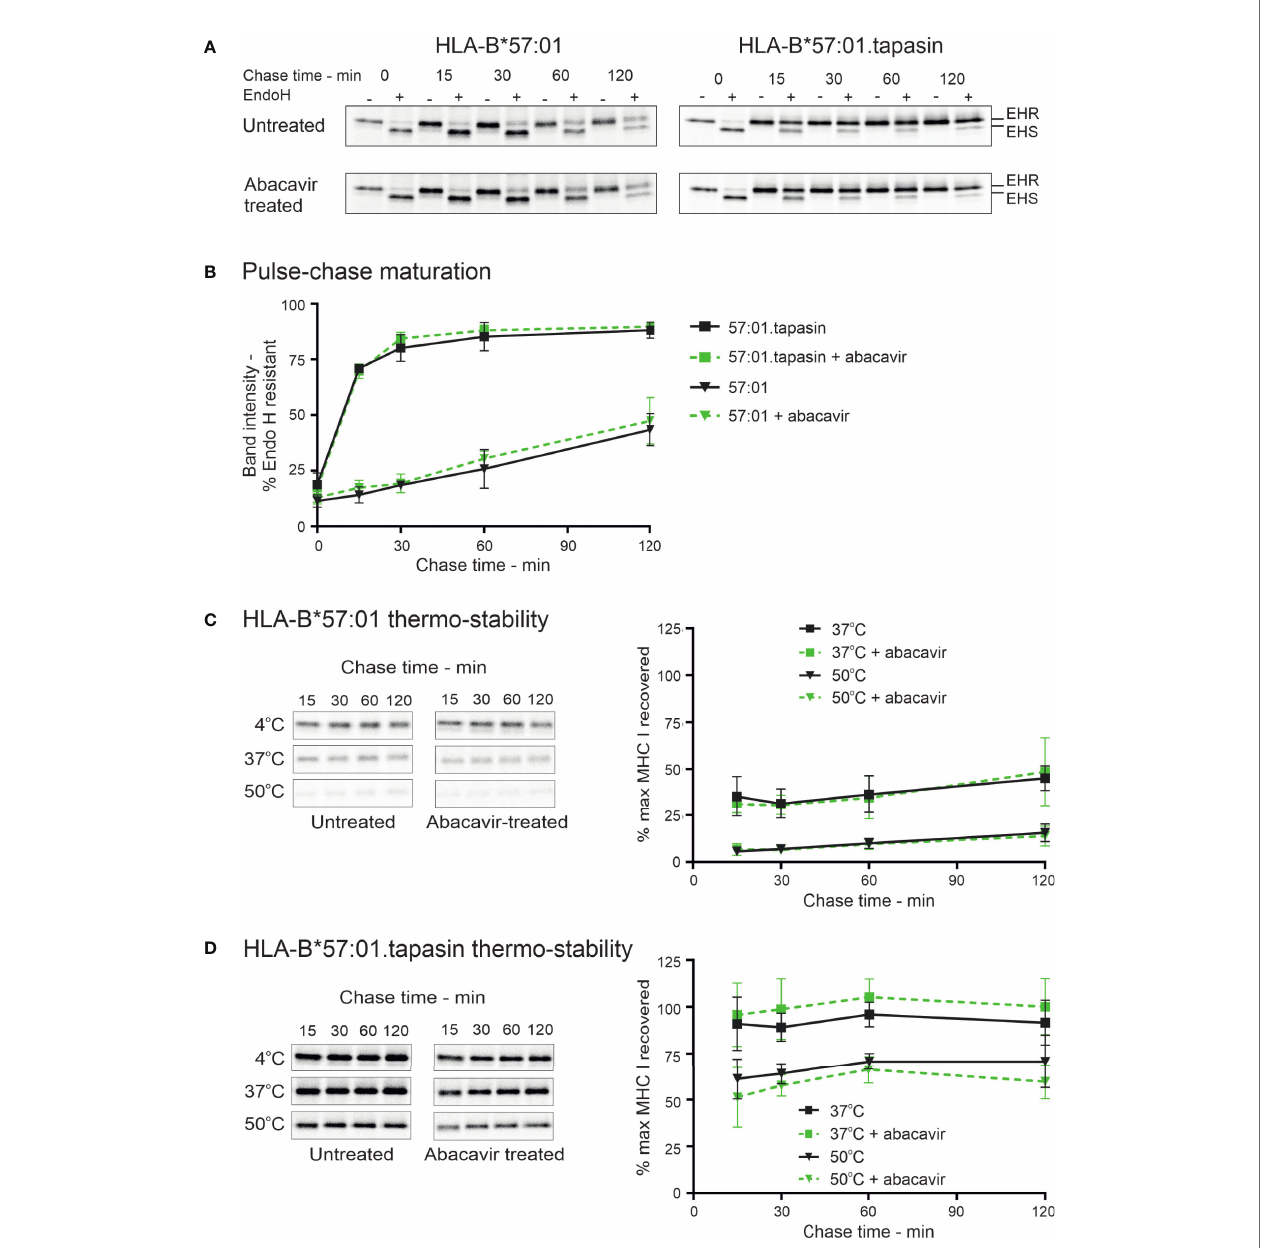
FIGURE 4 | Abacavir does not signi fi cantly alter maturation or global stability of HLA-B*57:01. (A) and (B) Maturation [acquisition of resistance to digestion with endoglycosidase-H (Endo-H)] of HLA-B*57:01 molecules was determined by pulse chase in 721.220.B*57:01 or 721.220.B*57:01.tapasin cells, immunoprecipitation of MHC I molecules, and digestion with endoglycosidase-H. (A) depicts representative SDS-PAGE gels for untreated and abacavir treated cells; only the HLA-B*57:01 heavy chain bands are shown. The location of Endo-H resistant (EHR) and Endo-H sensitive (EHS) bands is distinguished by their altered migration pattern. (B) The % EHR material was calculated [EHR/(EHR+EHS)] and plotted as the mean (+/ − SD) of three or four replicate experiments for abacavir treated and untreated cells respectively excluding time point 15, which was only included in two experiments. Abacavir had no apparent impact on HLA-B*57:01 maturation in either the presence or absence of tapasin. (C) and (D) Pulse-chase thermostability assays were performed in 721.220.B*57:01 (C) and 721.220.B*57:01.tapasin (D) cells: lysates were prepared from pulse radio-labelled cells and incubated at either 4, 37, or 50°C before b 2 m associated MHC I molecules were immunoprecipitated using W6/32 antibody and resolved by SDS-PAGE. Representative SDS-PAGE gels for untreated and abacavir treated cells depict the HLA-B*57:01 heavy chain bands recovered at each chase time after thermal denaturation. Graphs show the amount of HLA-B*57:01 molecules recovered after thermal denaturation at 37 and 50°C as a percentage of that recovered at 4°C (mean +/ − SD of four or fi ve replicate experiments for abacavir treated and untreated cells